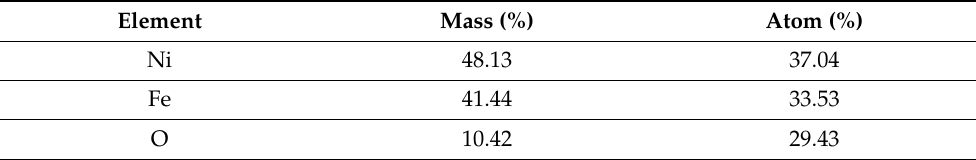
Table 1. Mass (%) and Atom (%) for FeNi using